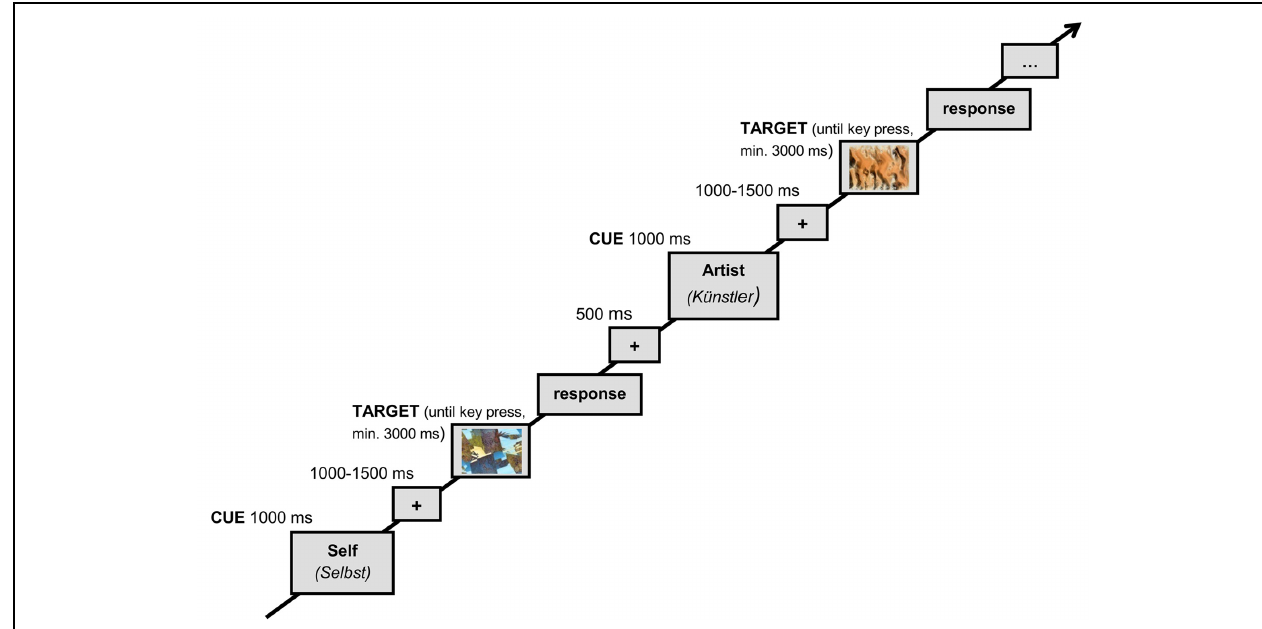
FIGURE 2 | Schematic demonstration of the experimental